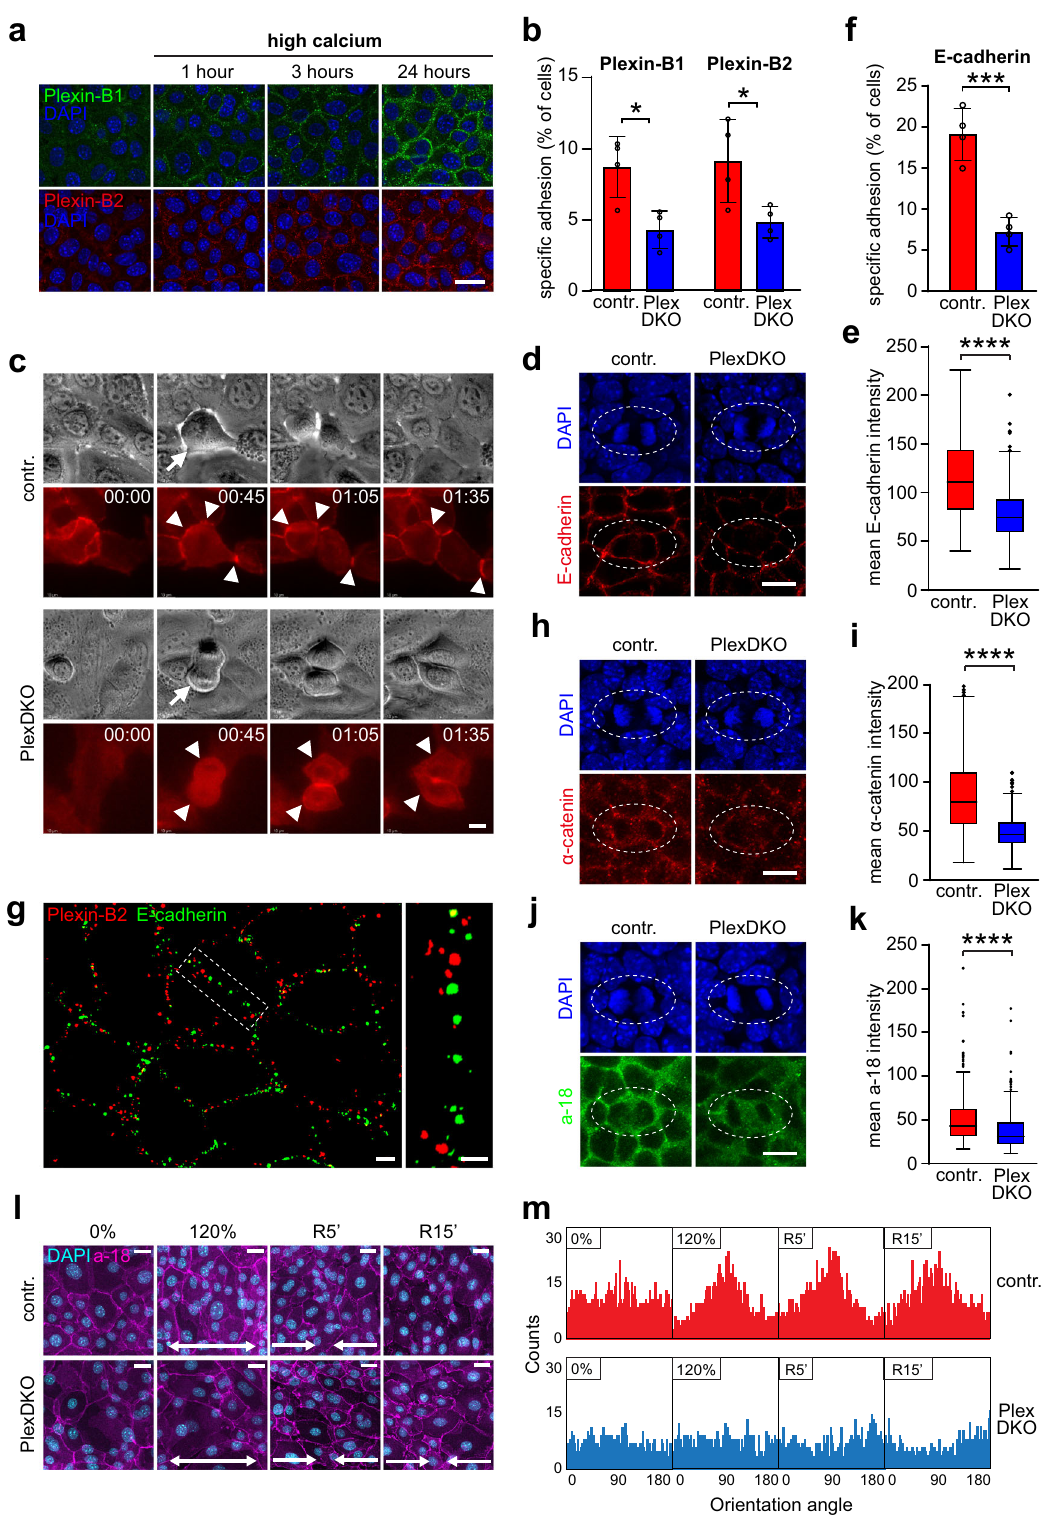
mechanical feedback on cell proliferation. Indeed, treatment of Plexin-B1/Plexin-B2-de fi cient mice with the chemical mitogen, the phorbol ester TPA (Supplementary Fig. 7a) resulted in higher proliferation rates (Supplementary Fig. 7b, c) and more pro- nounced epidermal thickening (Supplementary Fig. 7d, e) than in control mice. Fully in line with the function of